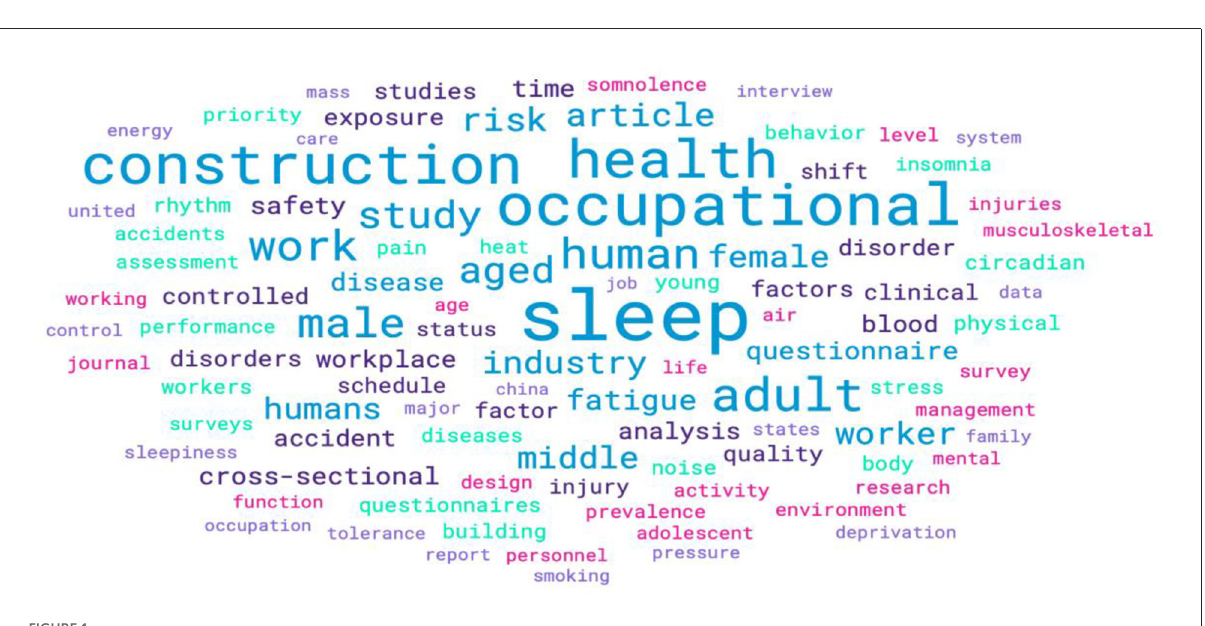
FIGURE1 Clustering of